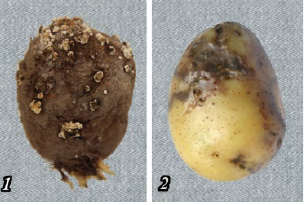
Figure 9. Identification of potato tubers by the Viola-Jones method: ( 1 ) damage localized in small areas, ( 2 ) damage in large areas.